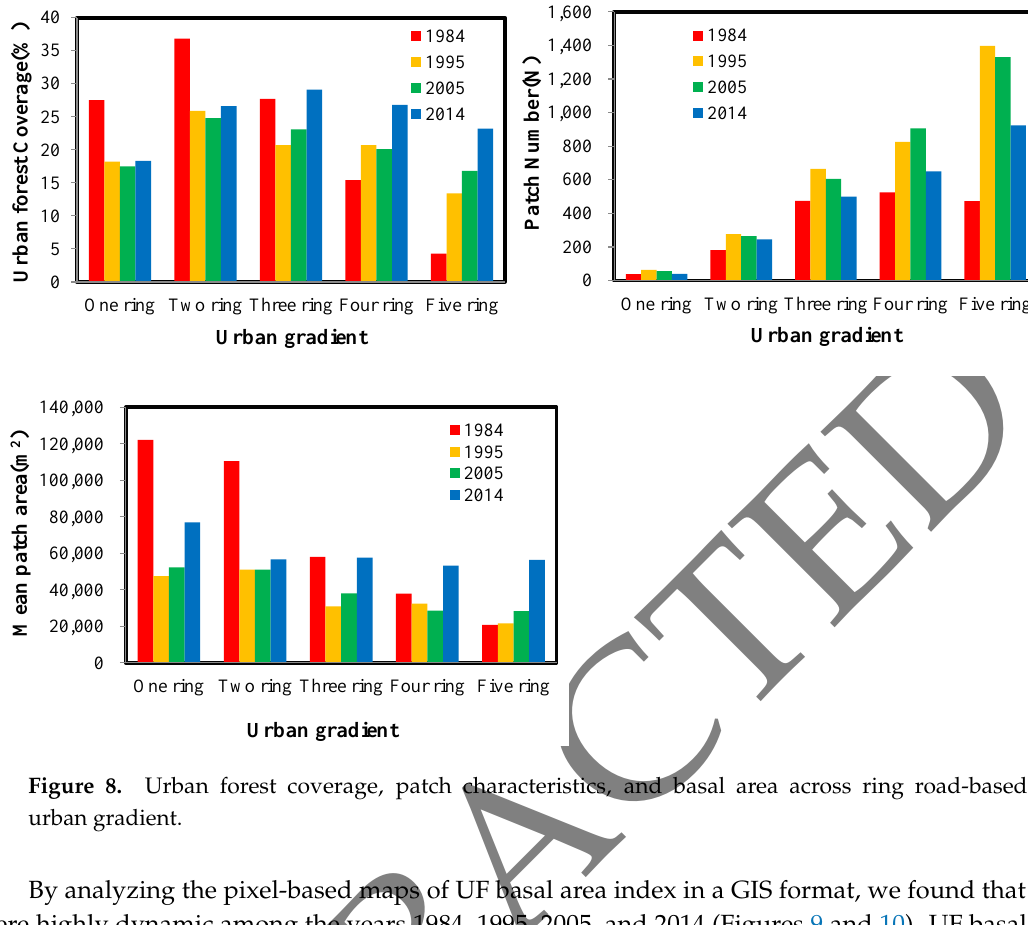
Figure 8. Urban forest coverage, patch characteristics, and basal area across ring road-based urban gradient.